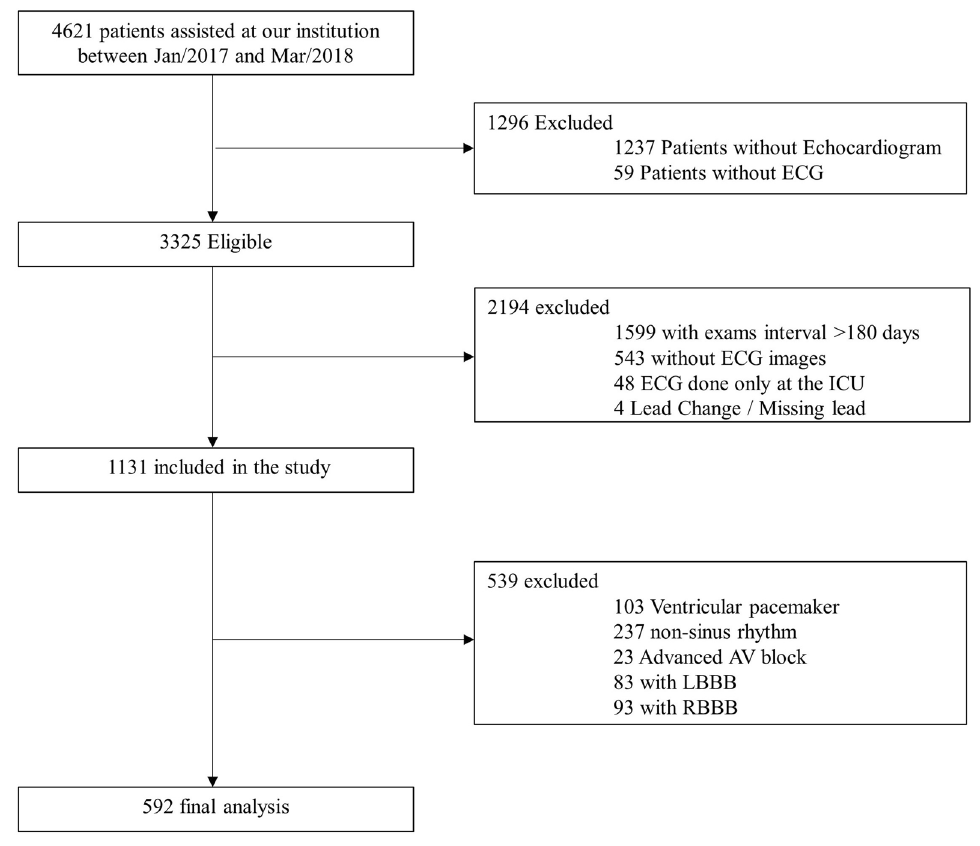
Figure 1. Study flowchart. ECG electrocardiography; ICU intensive care unit; LBBB left bundle branch block; RBBB right bundle branch